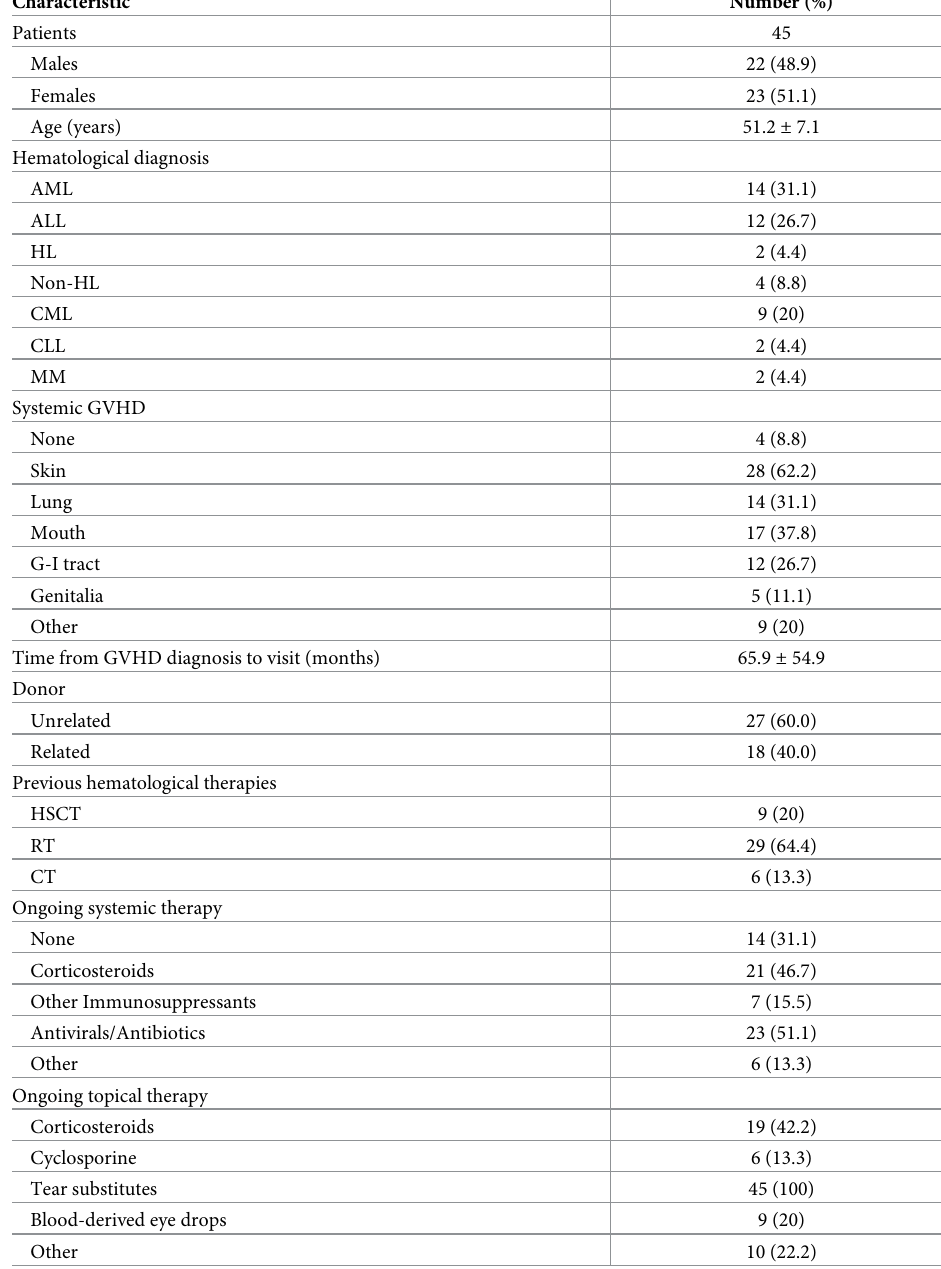
Table 1. Demographic and clinical parameters of patients with ocular